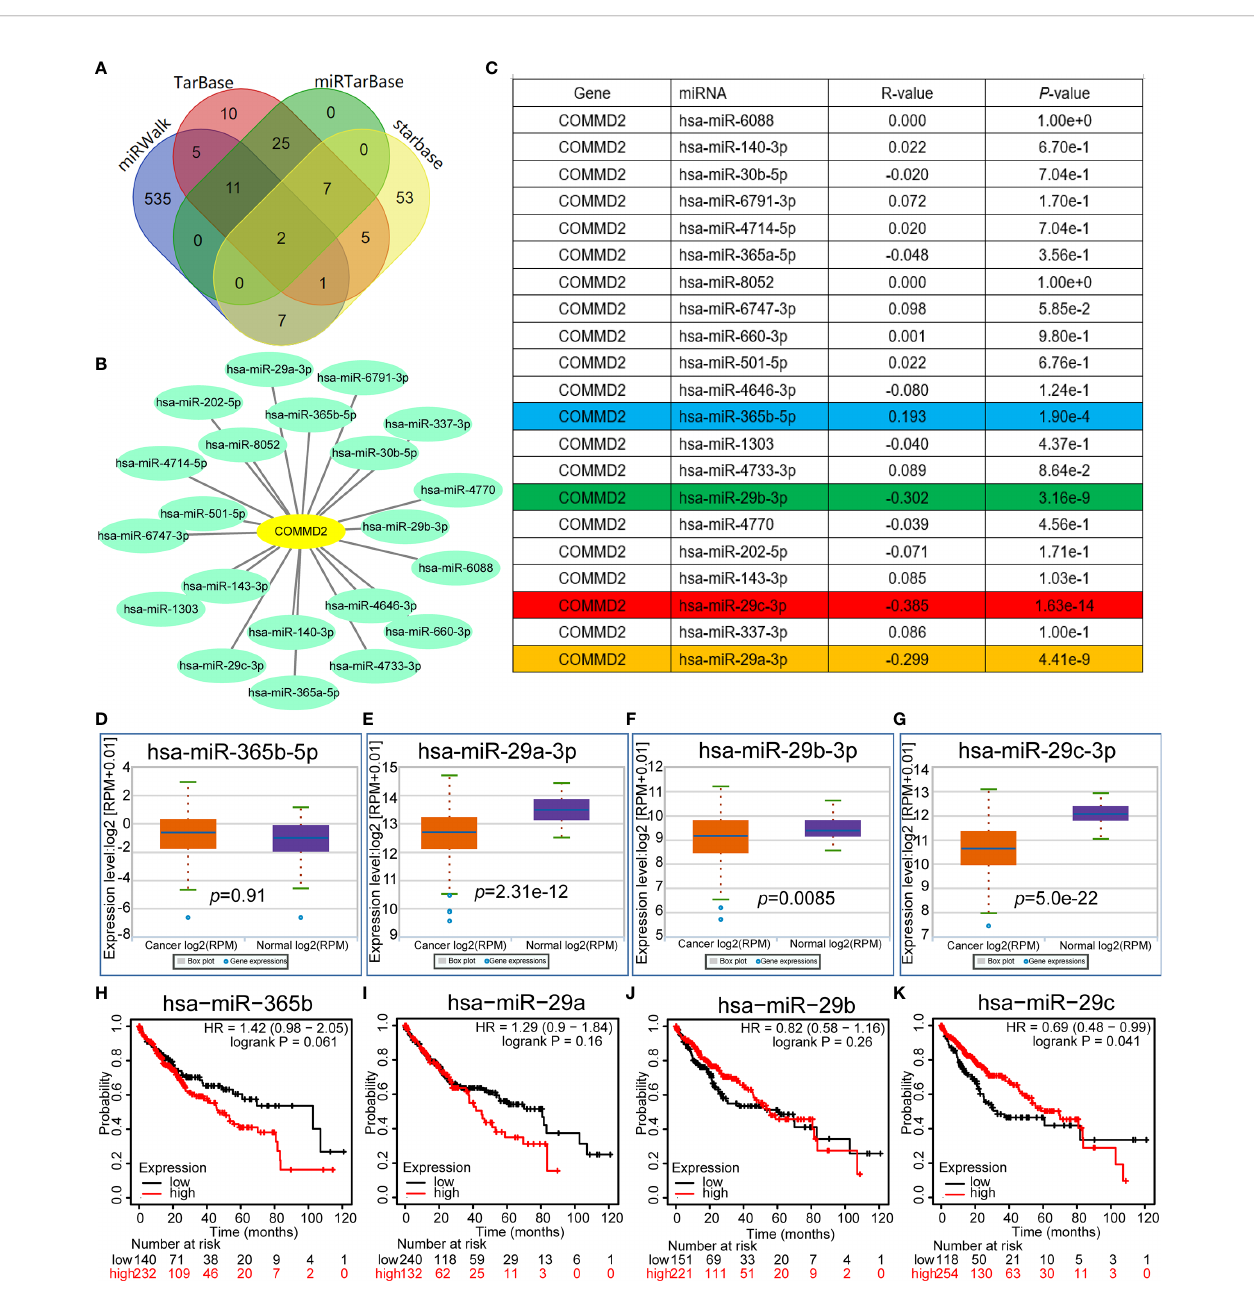
FIGURE 4 | Prediction and analysis of miRNAs upstream of COMMD2. (A) miRNAs predicted to be upstream of COMMD2 using the miRWalk, TarBase, miRTarBase and starBase databases. (B) miRNA-COMMD2 regulatory network established using Cytoscape software. (C) Correlations between the predicted miRNAs and COMMD2 in LIHC as determined by the starBase database. (D – G) Expression of miR-365b-5p (D) , miR-29a-3p (E) , miR-29b-3p (F) and miR-29c-3p (G) in LIHC and normal tissue samples as determined by the starBase database. (H – K) Prognostic values of miR-365b-5p (H) , miR-29a-3p (I) , miR-29b-3p (J) and miR-29c-3p (K) in LIHC as assessed by Kaplan-Meier